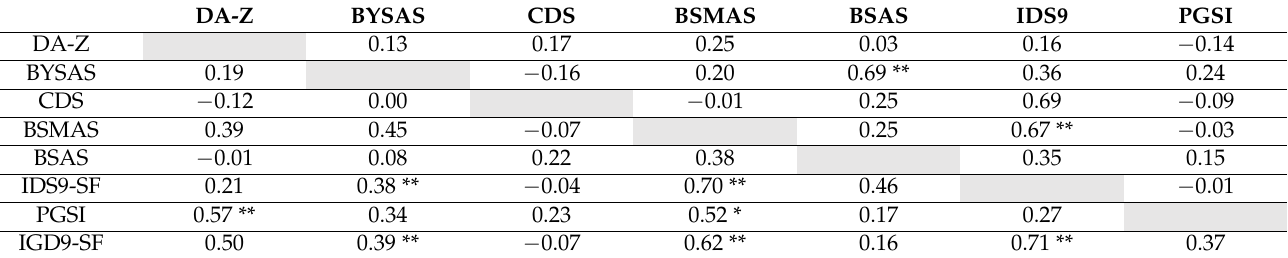
Table 5. Spearman’s rho correlations of non-gamers and gamers in the clinical